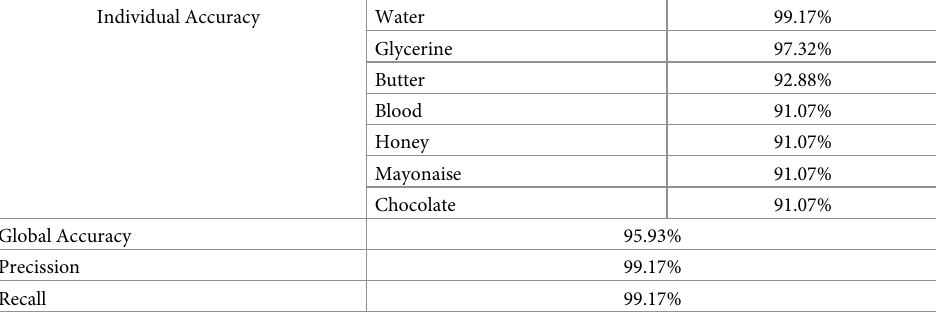
Table 2. Results obtained from classification after random forest training with k-fold cross